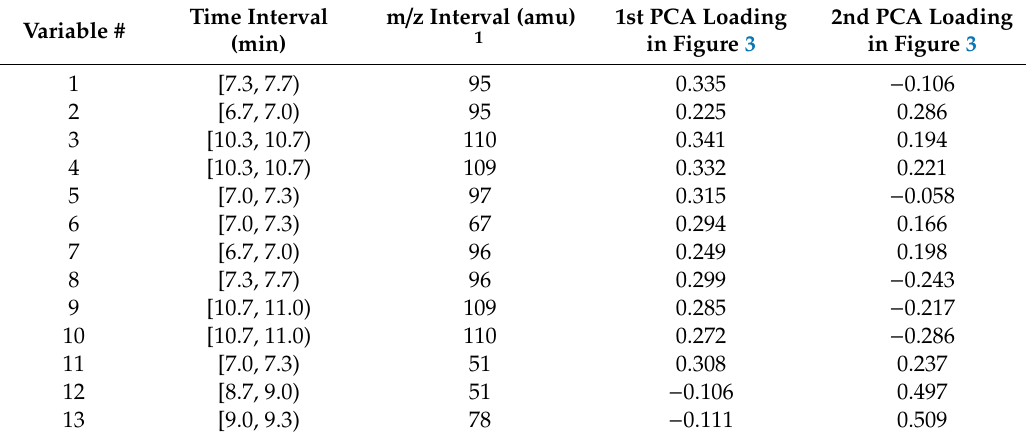
Table 2. Selected variables by SSIR after the binary codification of the